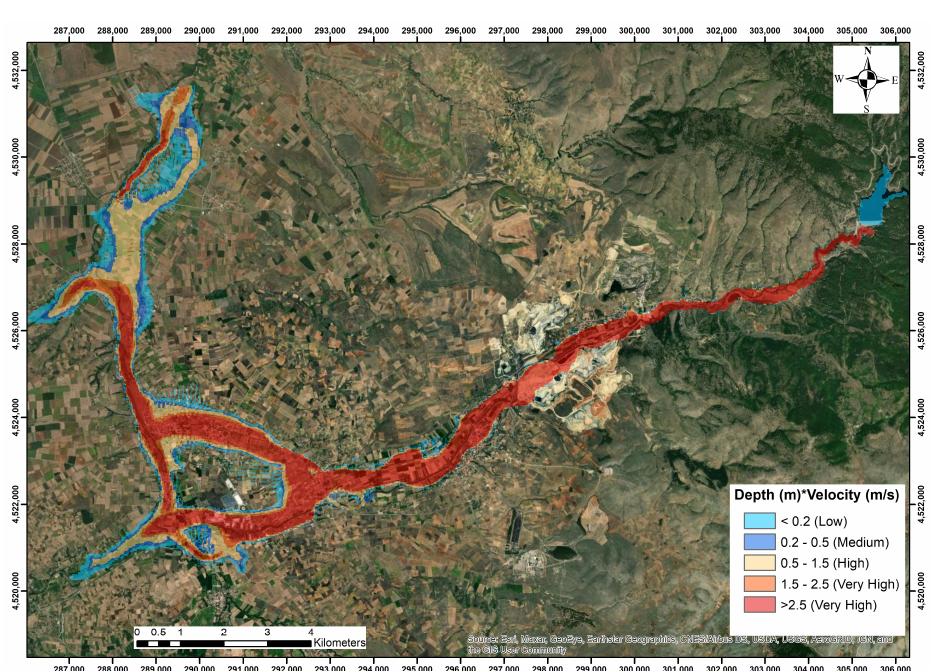
Figure 17. Flood hazard maps for the overtopping dam failure scenario (first classification approach).